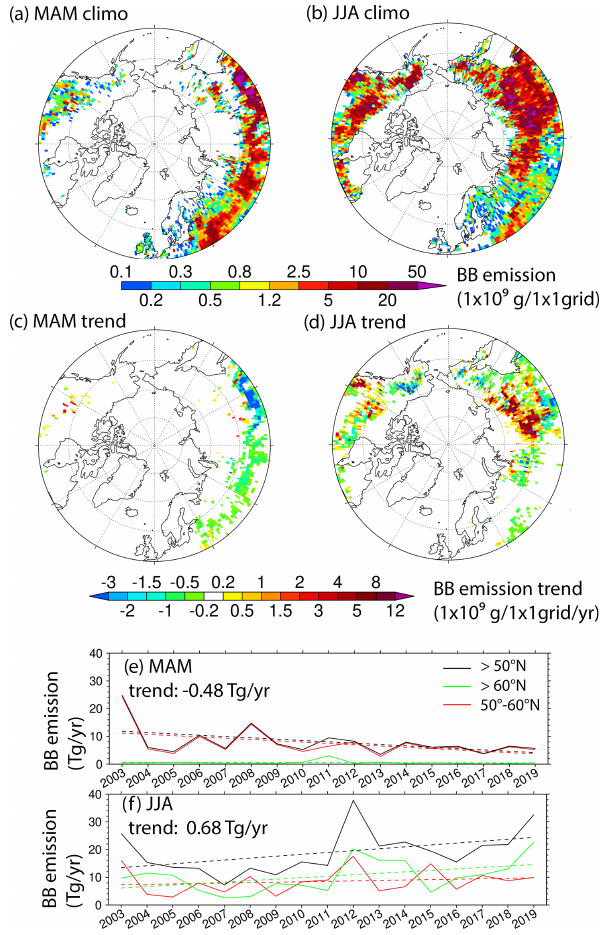
Figure 12. MAM and JJA seasonal total BB smoke particle emission climatologies and trends for 2003–2019 derived from FLAMBE. Panels (e) and (f) : time series of seasonally binned area- mean ( > 50 ◦ N, > 60 ◦ N, and 50–60 ◦ N) BB smoke (PM 2 . 5 parti- cle) emissions for MAM and JJA, respectively. Dashed lines rep- resent linear trends, which are statistically significant with a confi- dence level of 95%. The trend for north of 50 ◦ N is displayed in the